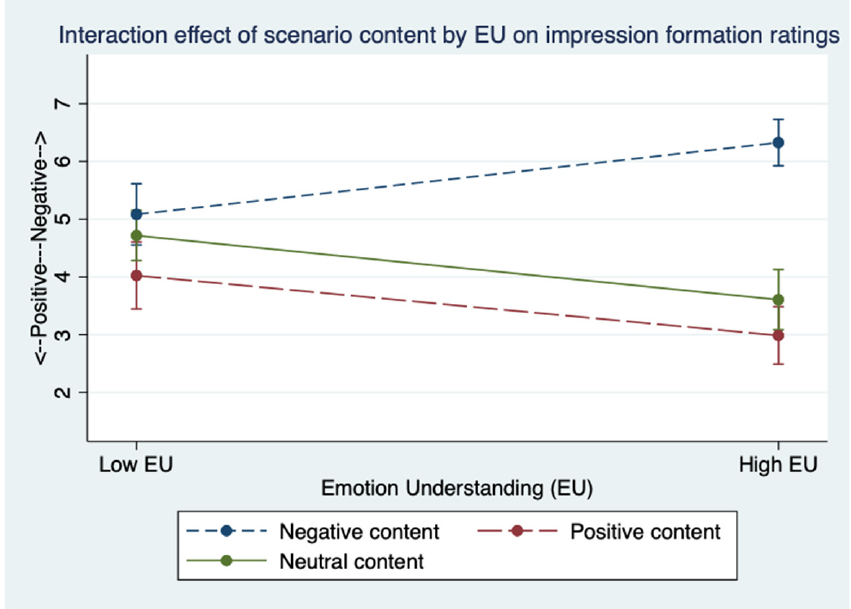
Figure 2. Interaction effect of EU (Emotion Understanding) by scenario content on ratings of Donald. High and low Emotion Understanding are calculated as ±1 SD from the mean.